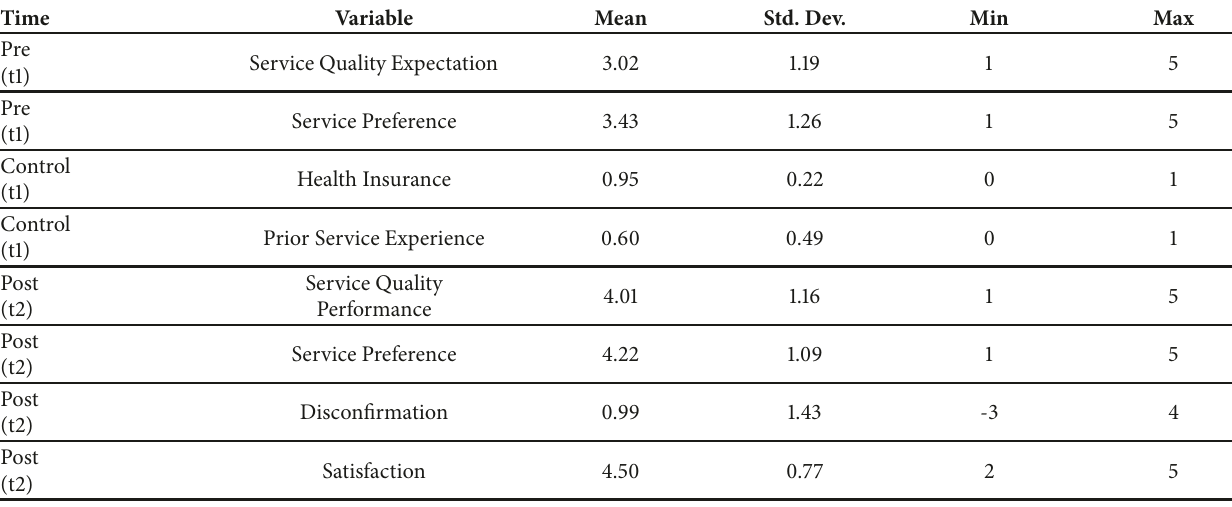
Table 2: Descriptive statistics of variables (n=220).